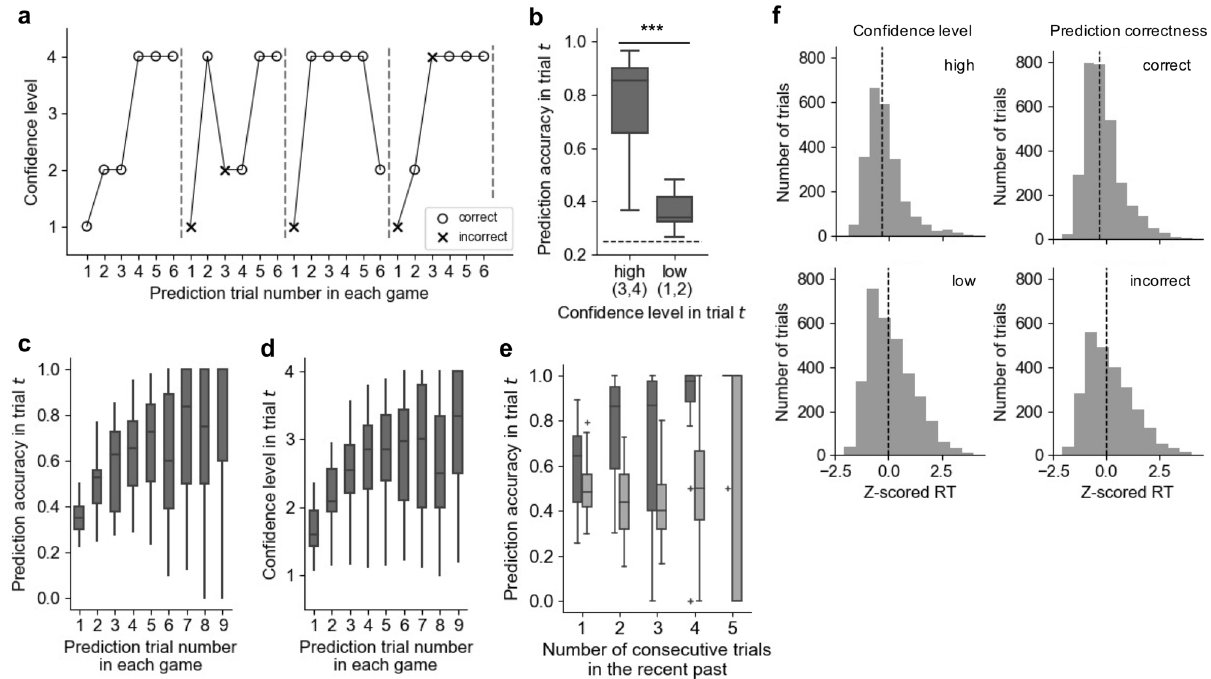
Fig. 2 Behavioral results. a Representative example of a sequence of subject ’ s reported con fi dence levels for scene predictions during four consecutive games. Each marker represents the con fi dence level chosen in the prediction trial; circle and cross markers denote whether the subject ’ s chosen prediction was correct and incorrect, respectively. The prediction trials are visibly interspersed by action trials. b The prediction accuracy was signi fi cantly higher when subjects ’ con fi dence levels were high (level 3 or 4) on the same trial (one-sided Wilcoxon signed-rank test, ***: p < 0.001). The dashed line indicates the chance level. Each box extends from the lower to upper quartiles, with a horizontal line at the median. The whiskers indicate 1.5 × IQR. c , d Scene prediction accuracy ( c ) and scene prediction con fi dence level ( d ) represented as a function of the prediction trial number in each game. Both the prediction accuracy ( r = 0.27, p = 1.3 × 10 − 5 ) and the con fi dence level ( r = 0.29, p = 2.6 × 10 − 6 ) increased as the number of prediction trials performed in a single game increased. Each box extends from the lower to upper quartiles, with a horizontal line at the median. The whiskers indicate 1.5 × IQR, and cross markers indicate the outliers. e Scene prediction accuracy as a function of the number of consecutive correct or incorrect choices in previous prediction trials. The prediction accuracy increased as the number of consecutive correct prediction trials increased (dim gray boxplot, r = 0.34, p = 6.6 × 10 − 5 ). In contrast, there was no correlation between prediction accuracy and the number of consecutive incorrect prediction trials (light gray boxplot, r = − 0.08, p = 0.35). Each box extends from the lower to upper quartiles, with a horizontal line at the median. The whiskers indicate 1.5 × IQR, and cross markers indicate the outliers. Each data point represents the average accuracy for a single subject. f Distributions of the scene choice reaction times (RTs) for all subjects. ART-ANOVA with con fi dence level (high and low) and prediction correctness (correct and incorrect) revealed that the RTs were shorter in high- con fi dence trials than in low-con fi dence trials ( p = 1.5 × 10 − 18 ) and shorter in the correct trials compared to incorrect trials ( p = 6.2 × 10 − 9 ). There was no interaction effect between prediction accuracy and con fi dence level ( p = 0.89). Each RT was converted to a z -score, normalized within each session for each subject. Vertical dotted lines indicate the median of each distribution. Note that the data shown in b – f was of 27 subjects included in the behavioral